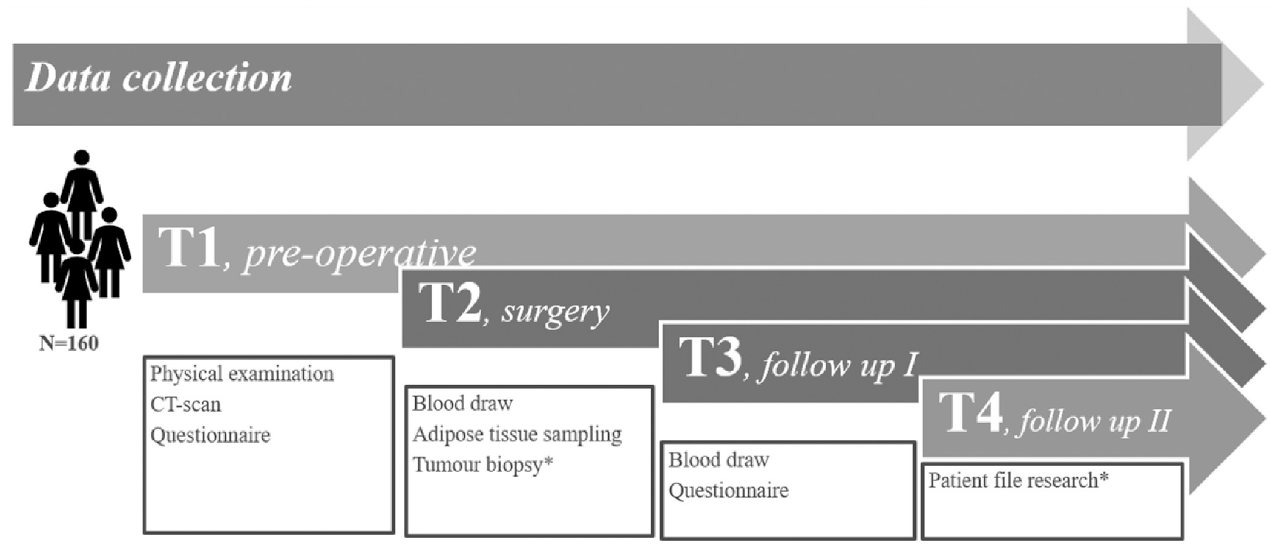
Fig 3. Schematic display of content and timepoints (T) for data collection during the study period. Three time points for patients with benign disease (T1-T3) and four time points (T1-T4) for patients with endometrial cancer (EC).